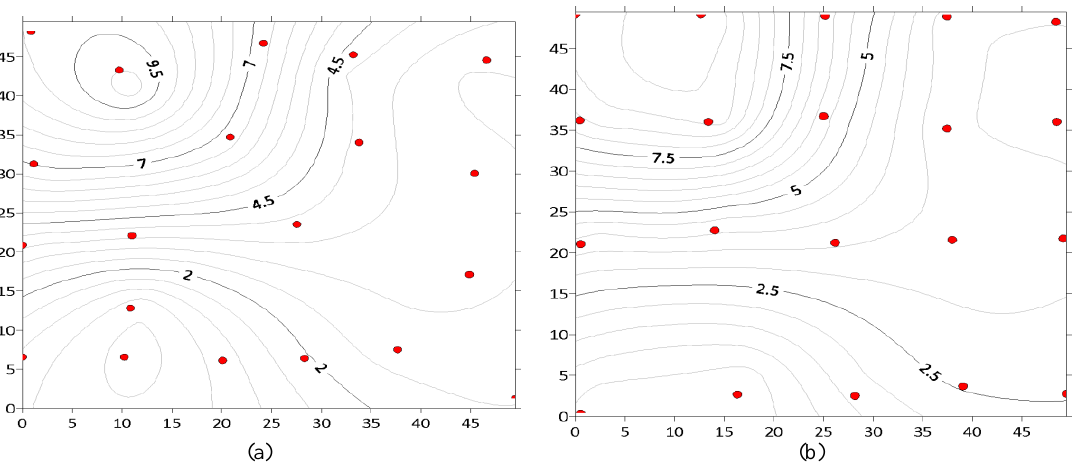
Figure 8. Contours and surveying points from the professional surveyor ( a ) and the student data ( b ).